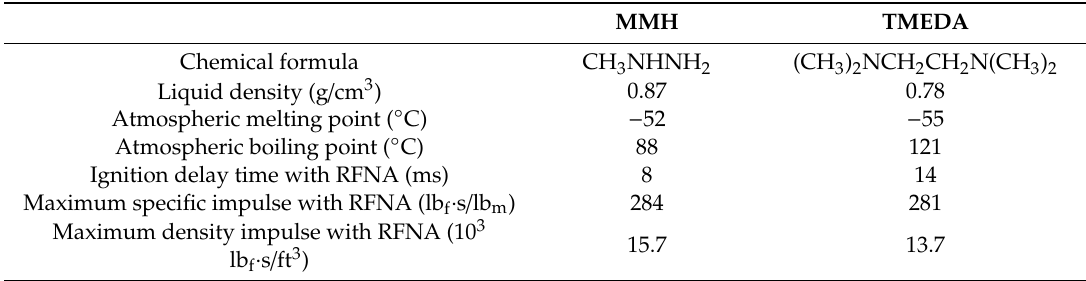
Table 1. Physical properties and performance parameters of monomethylhydrazine (MMH) and